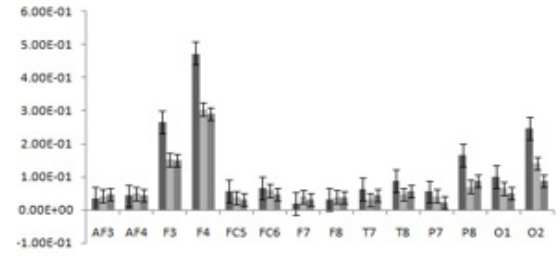
Figure 7. Engagement index for each channel on Baseline (BL), Low workload level (LWL) and high workload Level (HWL)